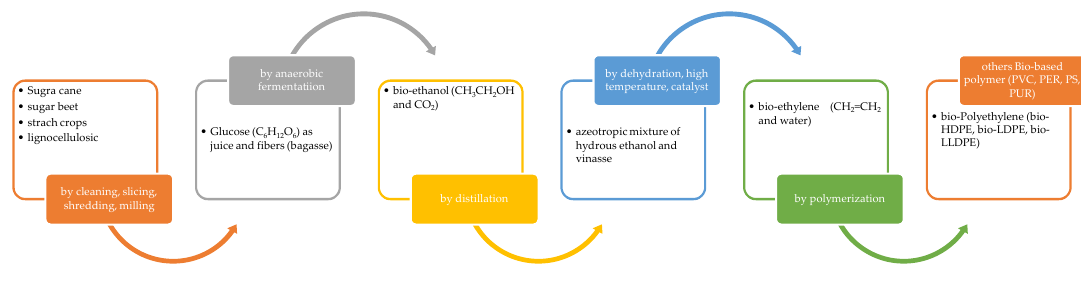
Figure 6. General scheme for Bio-PE production.